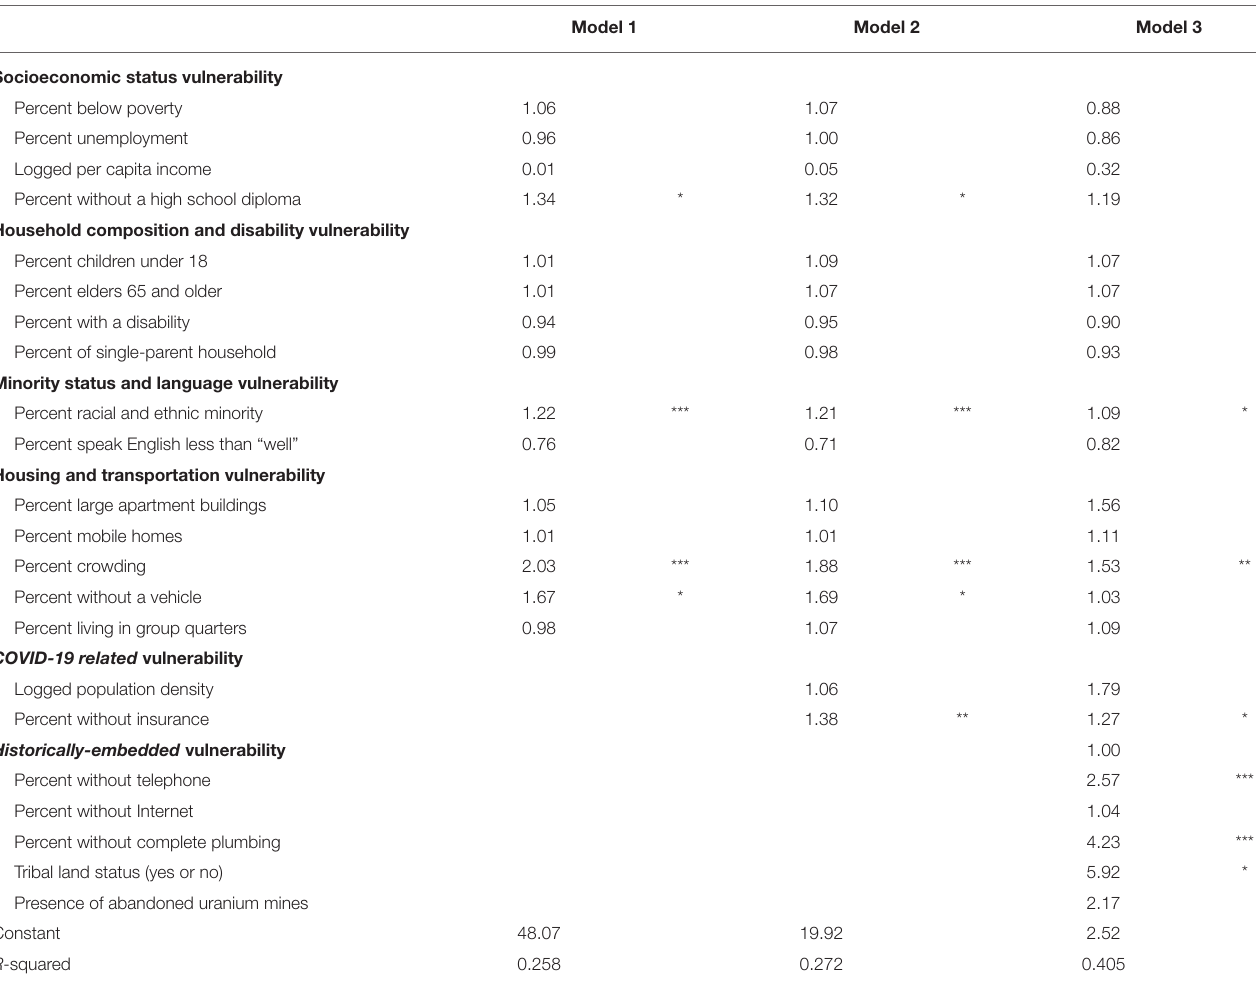
TABLE 2 | OLS exponentiated regression results predicting confirmed COVID-19 cases per